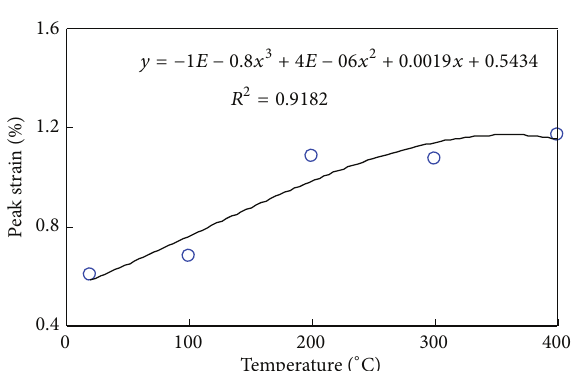
Figure 12: Peak strain variation curve with temperature with constant confining